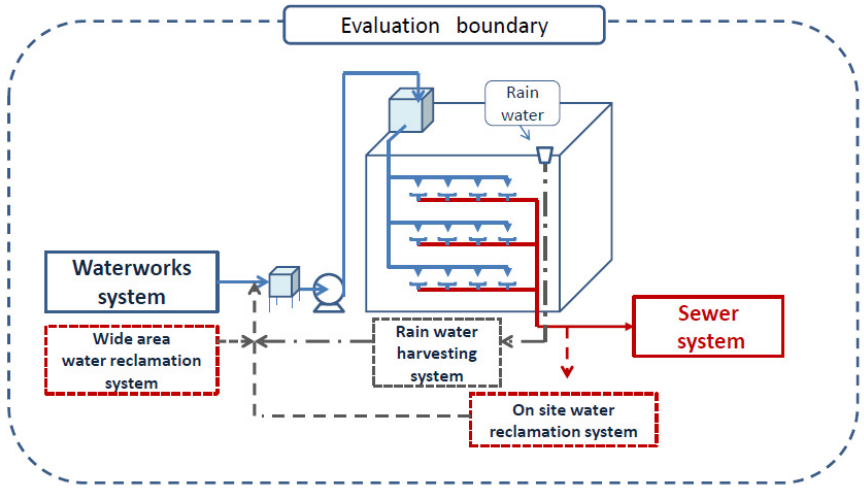
Figure 1. Evaluation boundary and